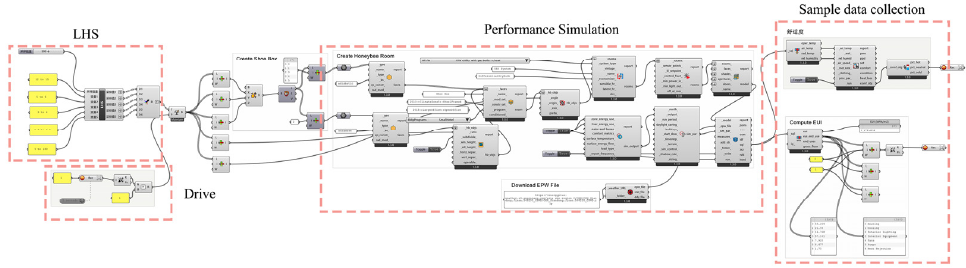
Figure 3. Performance simulation computing battery